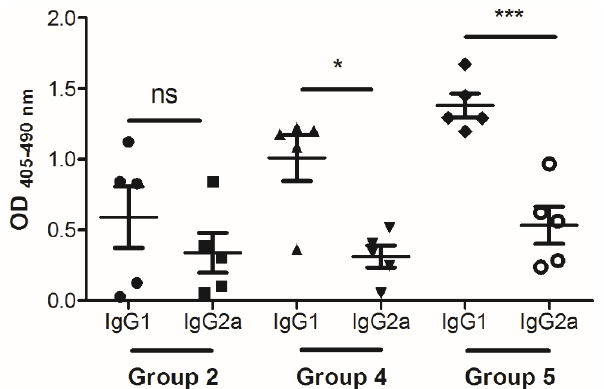
Figure 4. Levels of anti-nicotine IgG isotypes. Female BALB/c mice were administered intranasal instillations of different nicotine vaccine formulations and blood was collected two weeks post-vaccination. Individual mouse sera were diluted and anti-nicotine IgG1 and IgG2a were assessed on day 77. Data are represented as ± SEM, n = 5. Statistical significance was determined for Group 5 by an unpaired 2-tailed T-test, *** p = 0.0006, and for Group 4 by a Mann–Whitney test, * p =